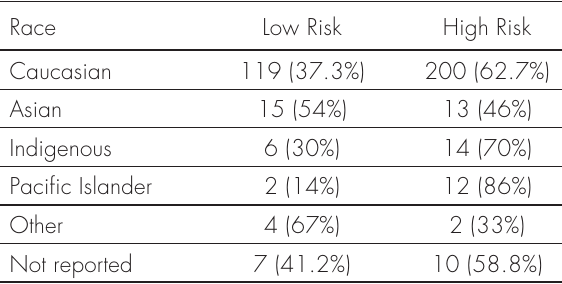
Table IV. Association between race and risk category.